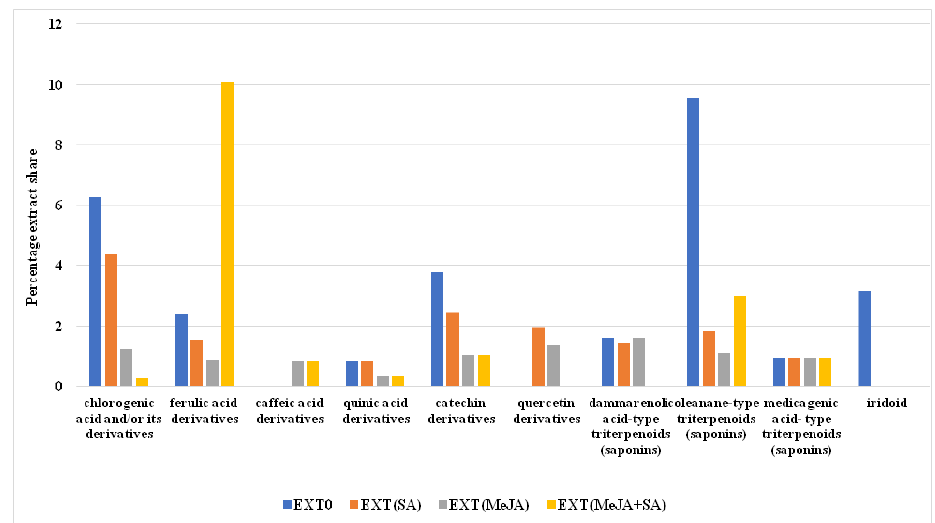
Figure 2. The percentage share of groups of chemical constituents in tested methanolic extracts of P. filicifolia determined on the basis of the UHPLC-DAD-MS/MS analysis. All of the tested extracts exhibit low cytotoxicity against the V79 cell line. IC 50 values are > 1 mg/mL. The highest inhibition of the viability was observed in the MTT assay for EXT0 and EXT(SA) in the concentration of 1 mg/mL: 14.3% and 13.5%, respectively (Figure 3).